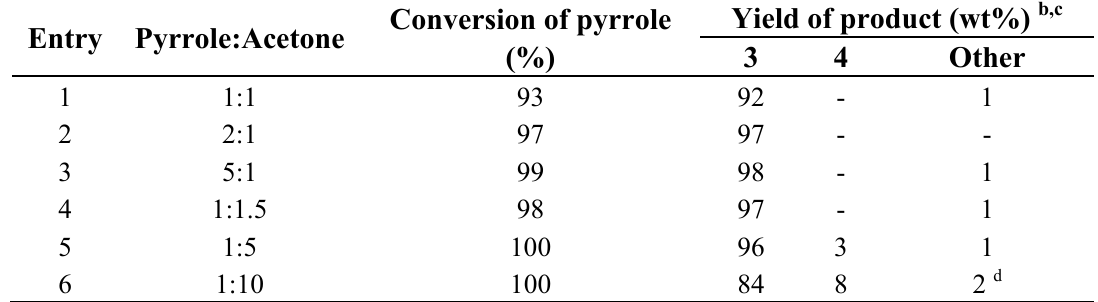
Table 2. Reaction of pyrrole and acetone in presence of graphite oxide in aqueous solution a .